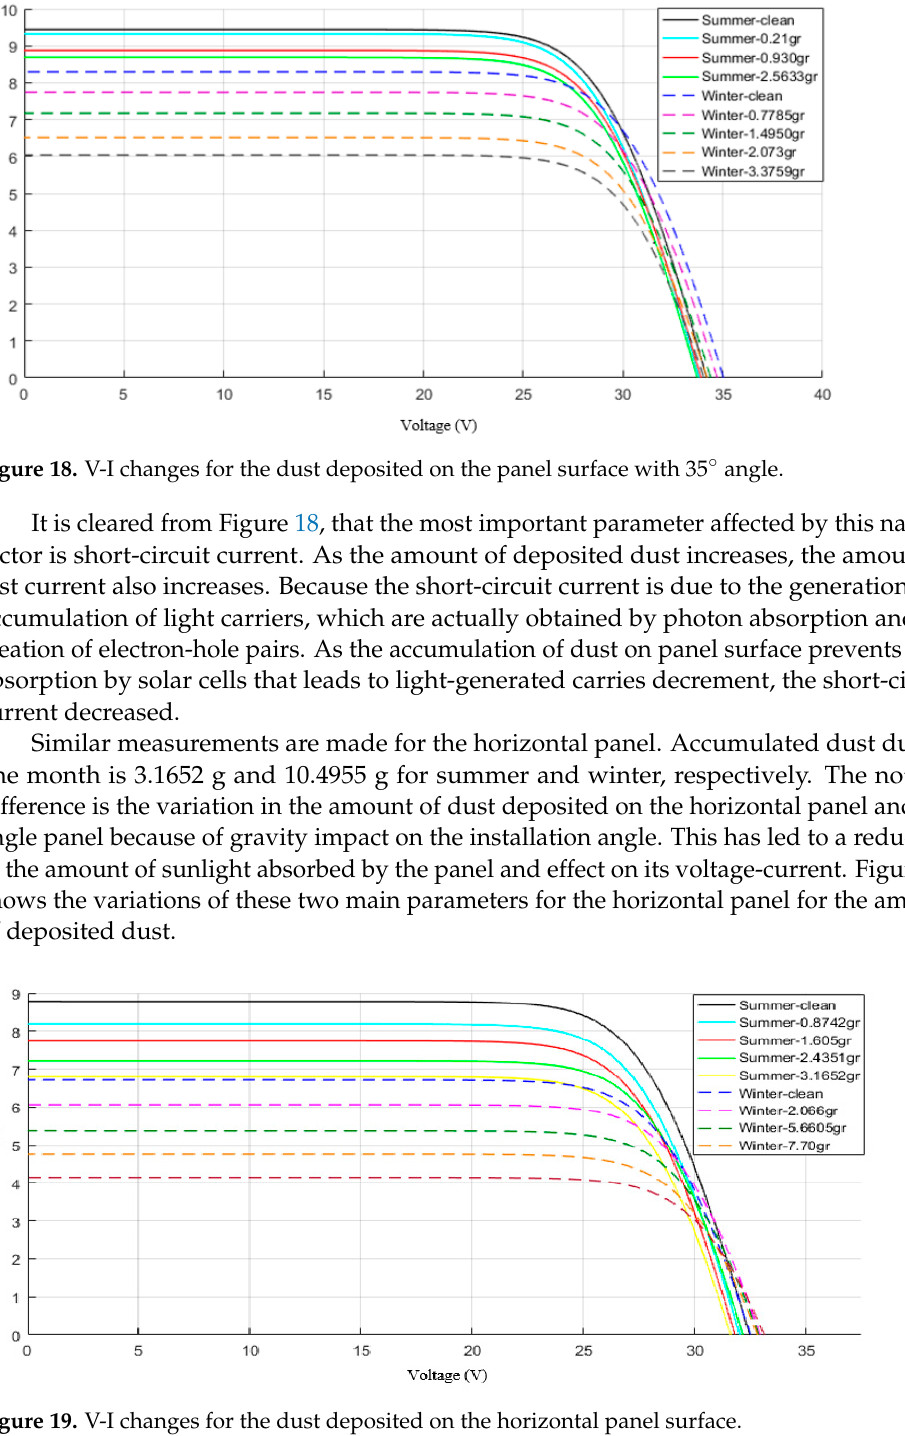
Figure 19. V-I changes for the dust deposited on the horizontal panel surface. In Table 3, the variations of the short-circuit for 35° and horizontal panels in summer and winter are shown. It is shown that increasing accumulated dust, decreasing short- circuit current. The short-circuit current is reduced by 8.42% and 27.27% for 35° panel for summer (accumulated dust is 2.5633 g) and winter (accumulated dust is 3.3759 g), as compared with a clean panel, respectively. The short-circuit current is reduced by 22.72% and 39.52% for horizontal panel for summer (accumulated dust is 3.1652 g) and winter (accumulated dust is 10.4955 g), as compared with a clean panel,